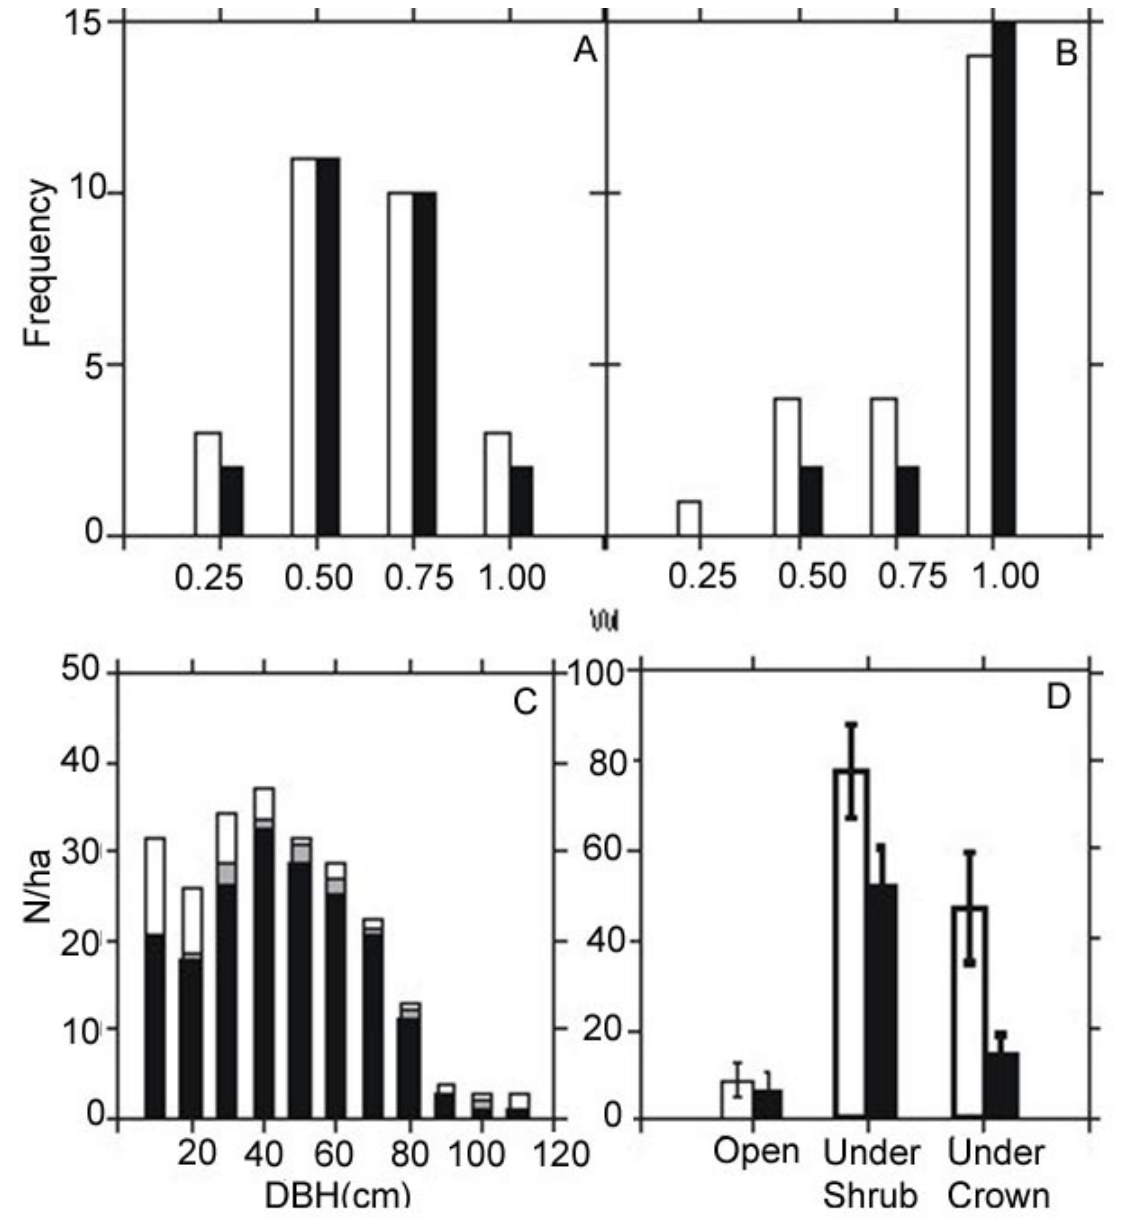
Fig. 2. Changes in forest characteristics after a wildfire in an unmanaged Jeffrey pine-mixed conifer forest in northern Sierra San Pedro Martir (SSPM), northwestern Mexico ( n =27 plots): frequency distribution of Winkelmass (Wi) values for live trees (A) and live seedlings (B) (pre-wildfire, white bars; 1-yr post-wildfire, black bars), live-tree density (C) by size class (pre-wildfire, entire bars; 1-yr post-wildfire gray bars; 3-yr post-wildfire, black bars), and live-seedling density (D) by location relative to shrub and overstory crown cover (pre-wildfire, white bars; 1-yr post-wildfire, black